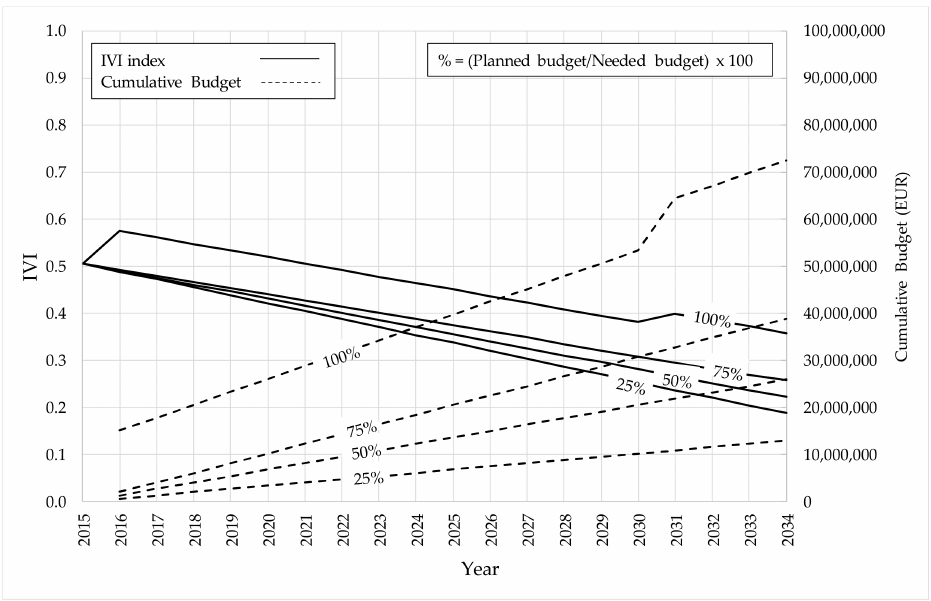
Figure 13. Asset 2 condition assessment with IVI under several future investment scenarios.